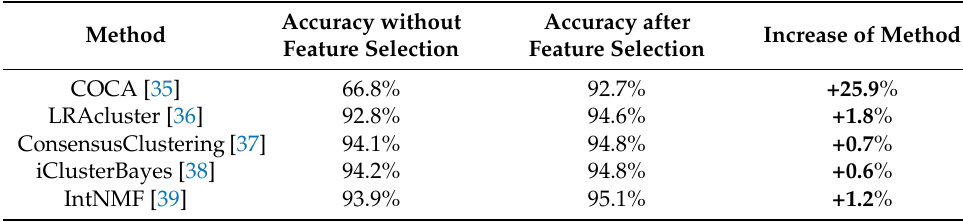
Table 6. Performance of five popular cancer subtypes identification